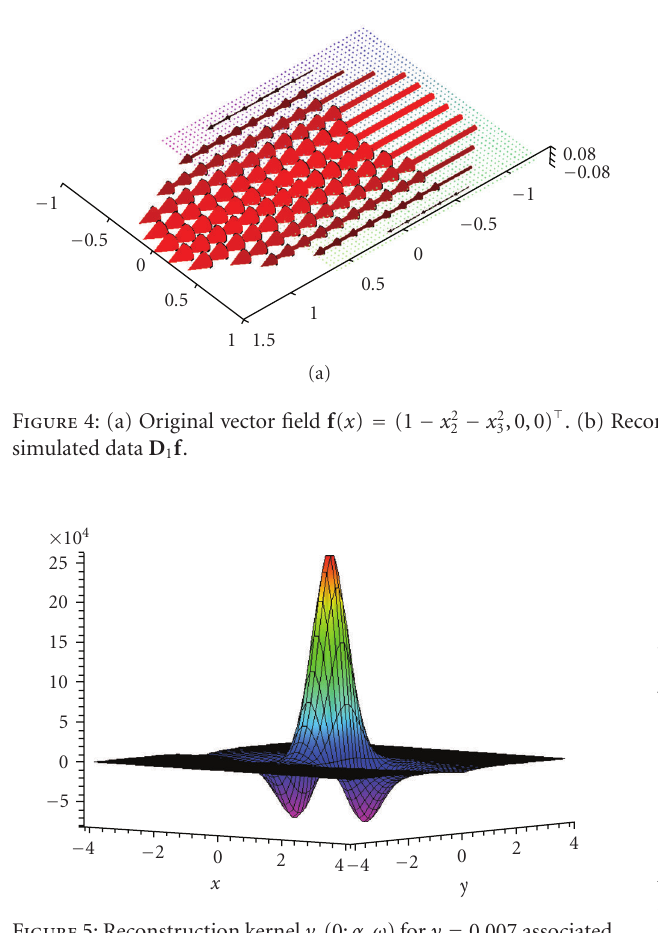
Figure 5: Reconstruction kernel v γ (0; α , ω ) for γ = 0 . 007 associated to the scalar cone beam transform D 0 according to